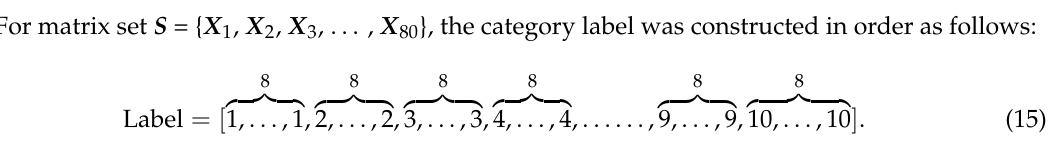
Figure 10. ( a ) Characteristic values the 80 samples for sensor 1; ( b ) normalized characteristic values of the 80 samples for sensor 1. ( c ) characteristic values the 80 samples for sensor 2; ( d ) normalized characteristic values the 80 samples for sensor 2.